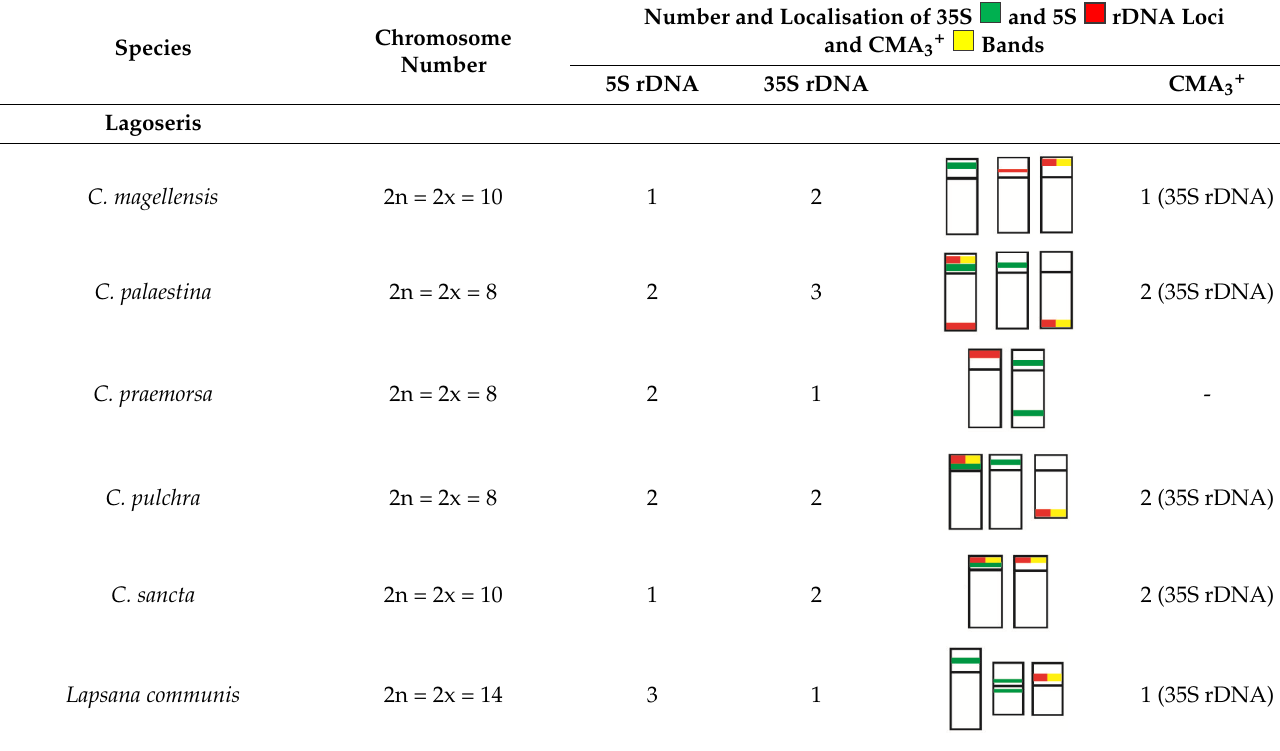
Table 1. The number and localisation of the 35S and 5S rDNA loci and CMA 3+ bands in Crepis .